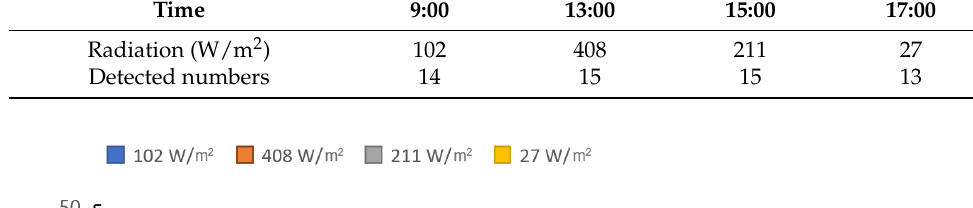
Table 2. Detection numbers of the flowers with varying levels of radiation at a different time on a sunny day in the greenhouse.